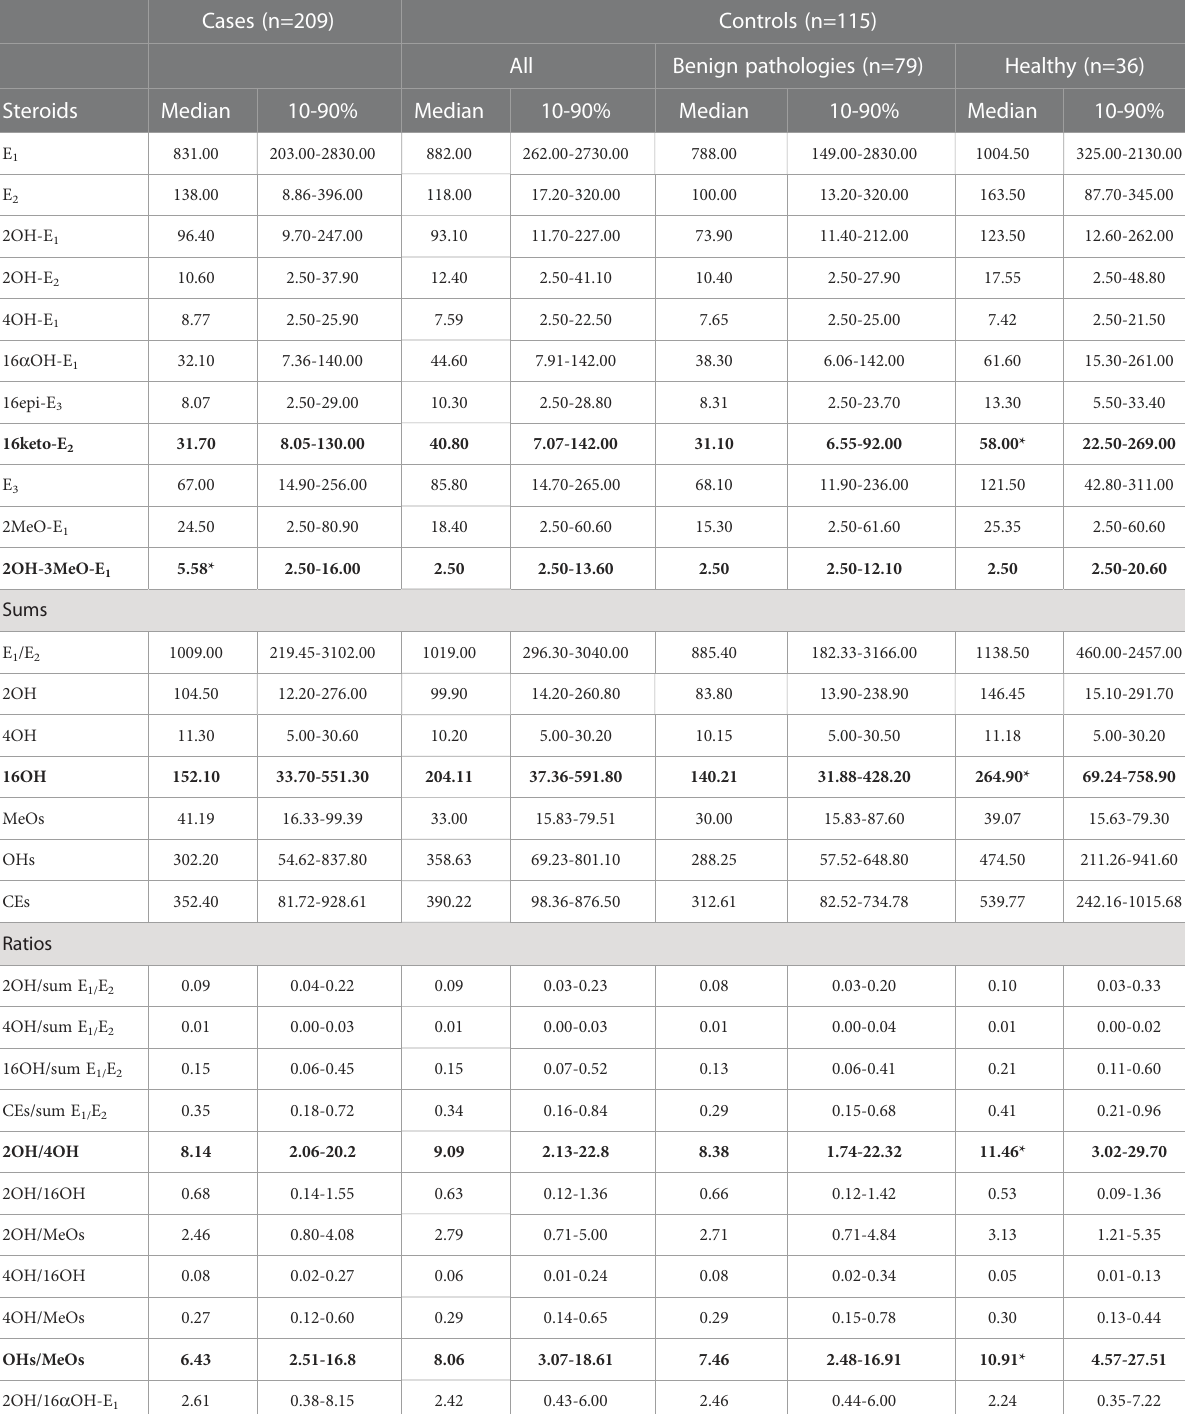
TABLE 2 Steroid levels for EM cases (n=209) and for controls (n=115) that included subjects with benign pathologies and healthy controls. Cases (n=209) Controls (n=115) All Benign pathologies (n=79) Healthy (n=36) Steroids Median 10-90% Median 10-90% Median 10-90%